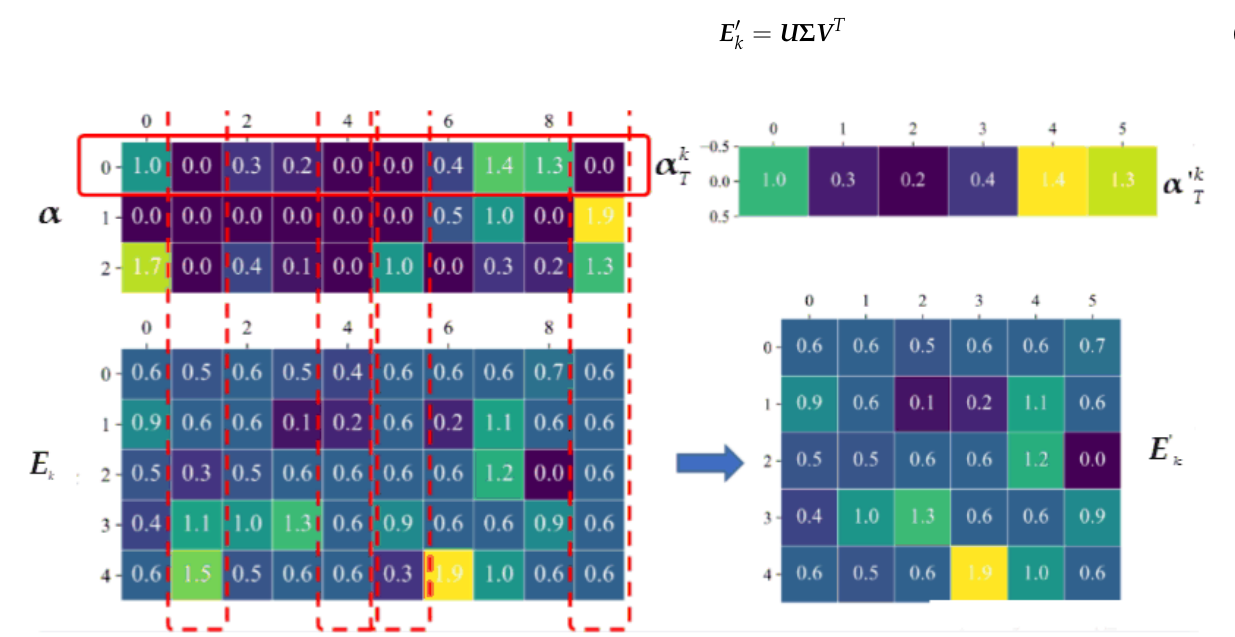
Figure 2. Schematic diagram of the OMP algorithm extracting partial residuals.